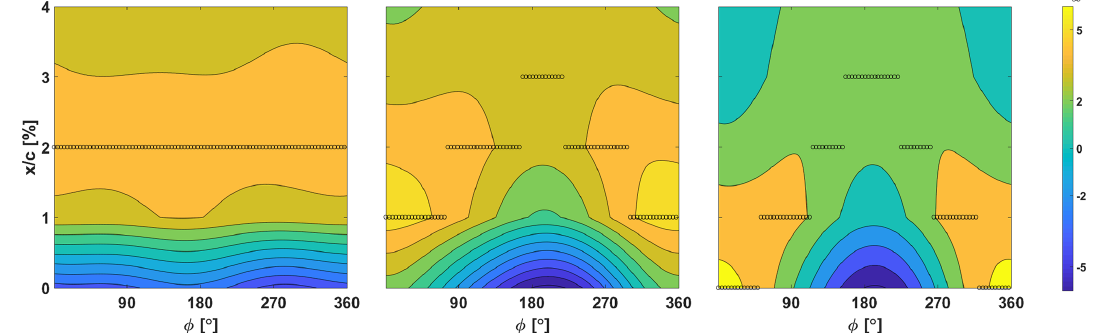
Figure 12. Pressure contours over the pressure side at r = 45% R in the range [ 0 , 4 ] % c for all yaw cases and pitch angle of θ = 0 ◦ . The circles ( ◦ ) are located at max { P } at that azimuth position and indicate the location of the stagnation point.